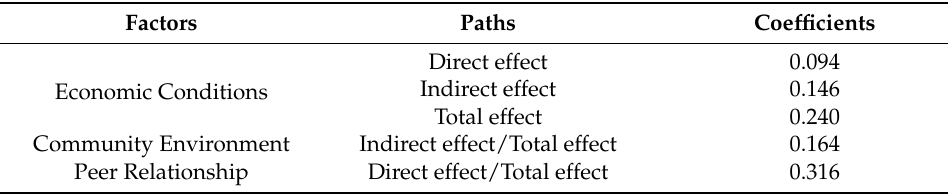
Table 3. Direct, indirect, and total effects of the